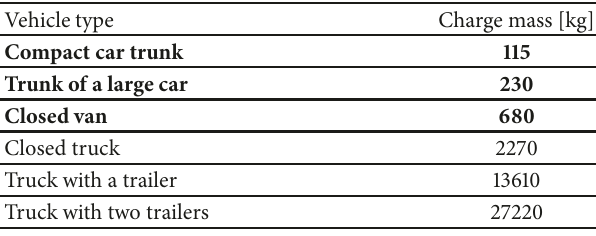
Table 1: Estimated quantities of explosives for various types of